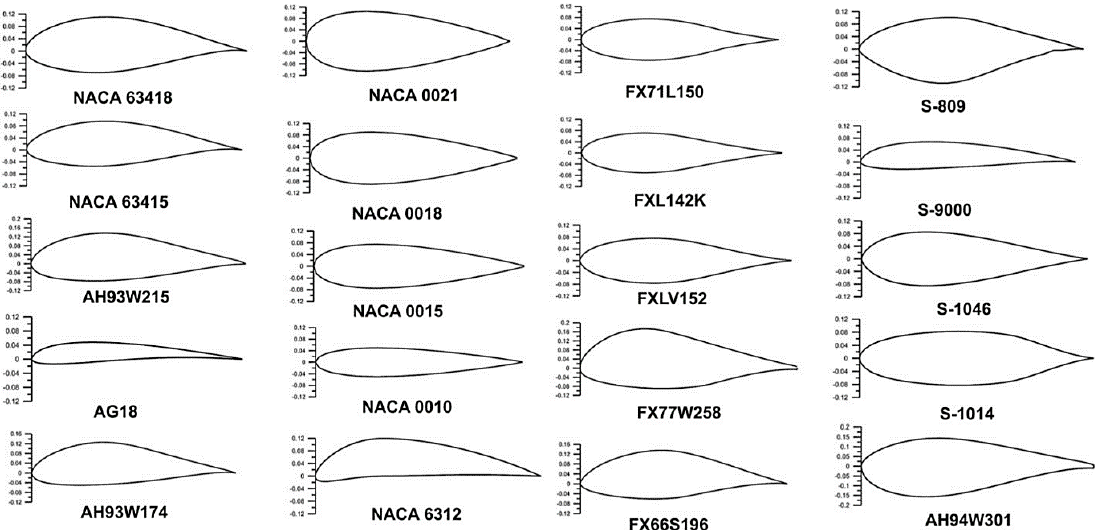
Figure 5. Different symmetric and non-symmetric aerofoils investigated in [30].